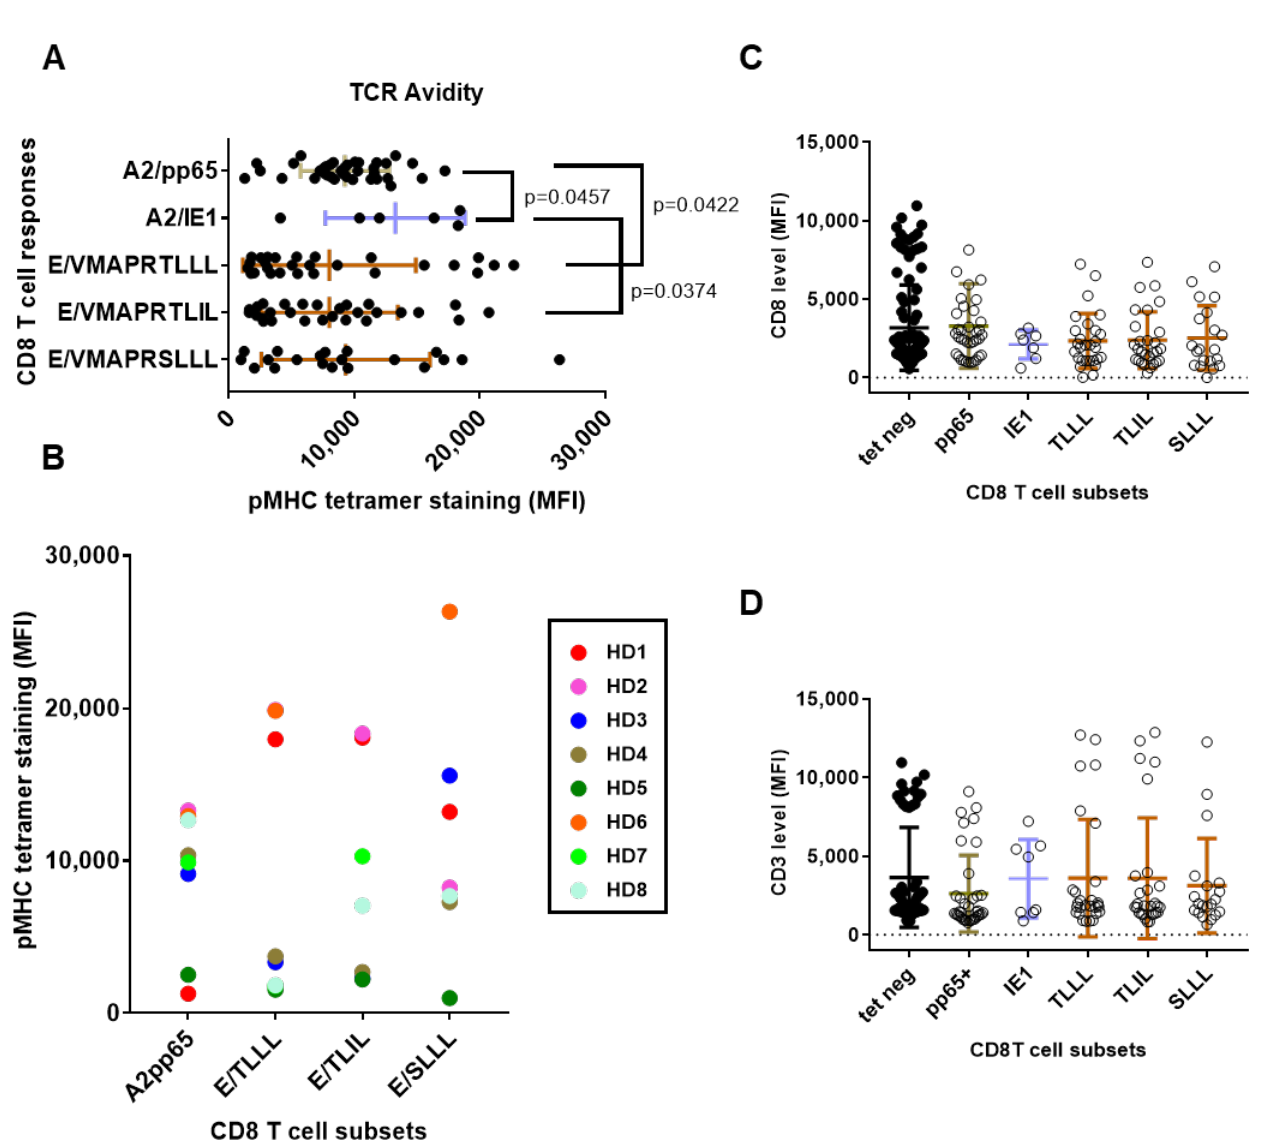
Figure 5. Characteristics of long-lasting HCMV-specific CD8 T cell responses according to HLA allele and peptide specificity: TCR avidity and co-receptor expression. ( A ) Scatter plots reporting the means of fluorescence intensity (MFI) for pMHC tetramer staining in the five subsets of HCMV-specific CD8 T cells. ( B ) Patterns of TCR avidity for HCMV-specific CD8 T cells according to HLA allele and peptide specificities. Relative pMHC tetramer staining for HLA-A2- versus HLA-E-reactive CD8 T cells for eight HCMV+ HD (HD1-HD8) with multiple CD8 T cell responses are reported on the graph. Each color corresponds to an individual HCMV+ HD. ( C , D ) Scatter plots reporting the MFI for CD3 ( C ) and CD8 ( D ) on the five subsets of HCMV-specific CD8 T cells and in pMHC tetramer-negative (tet neg) CD8 T cells from the same hosts. Each dot corresponds to a single, independent, CD8 T cell subset. Statistical analysis was performed by Mann–Whitney U -test; p values are